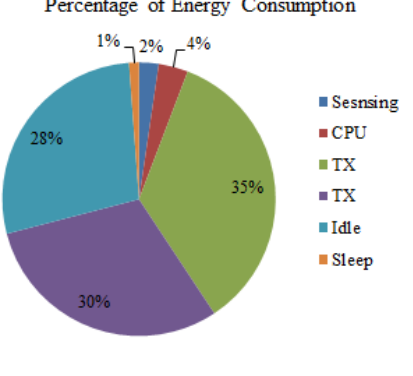
Figure 6. Percentage of energy consumption of sensor nodes